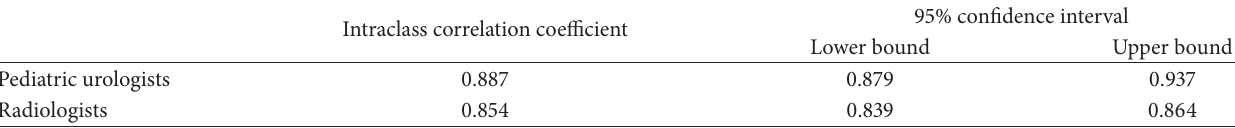
Table 3: Agreement between PR and PU on VCUG assessments.